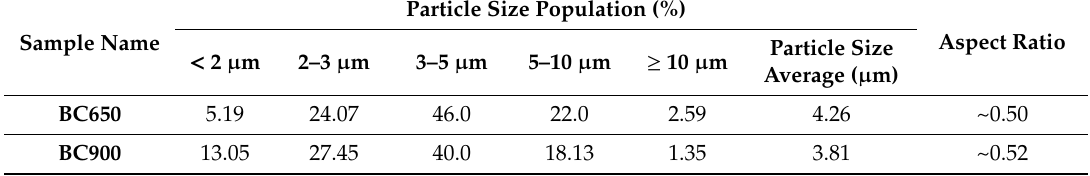
Table 1. Structural characterization of the biocarbon powder after ball-milling obtained by scanning electron microscopy. The particle size population and aspect ratio were measured by image-based particle size.